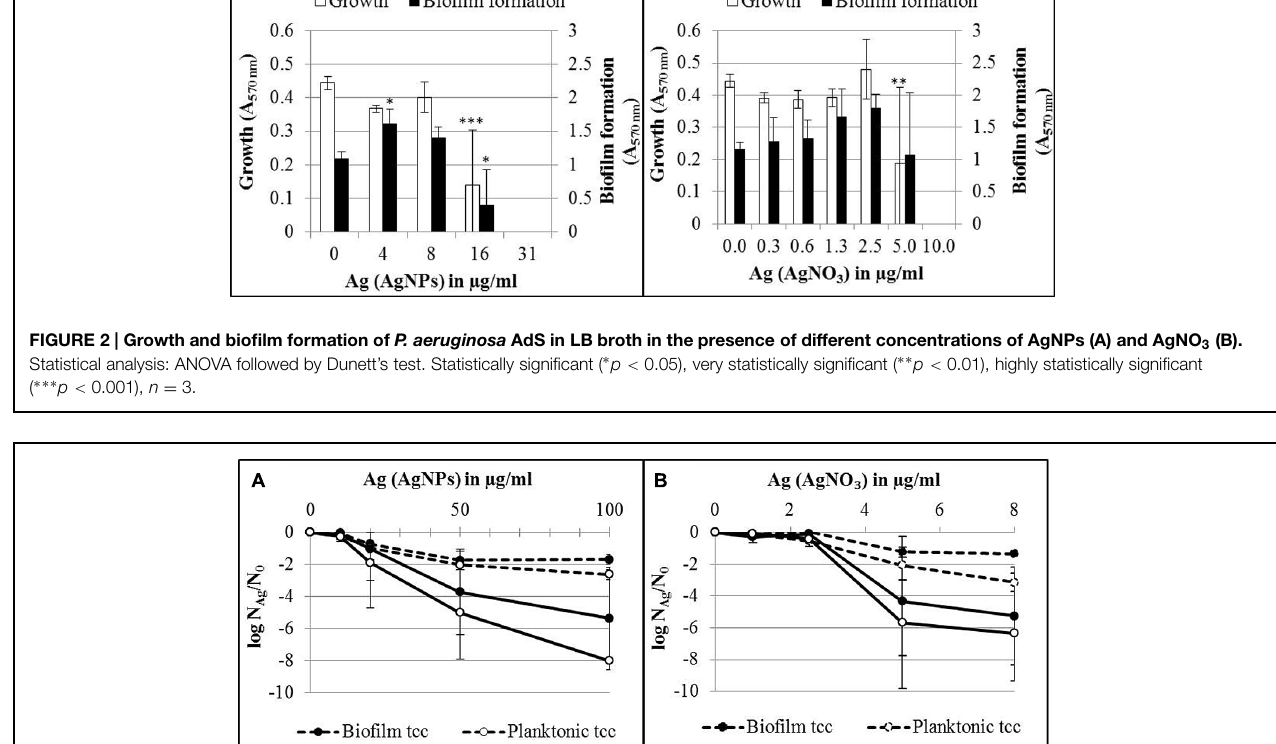
cells) over N 0 (culturability or total cell counts of the control without silver; Figure 3 ). Total cell number of the planktonic bac- teria was inhibited with statistical significance at 20 µ g/ml Ag for AgNPs ( p < 0.01) and 2.5 µ g/ml Ag for AgNO 3 ( p < 0.01).